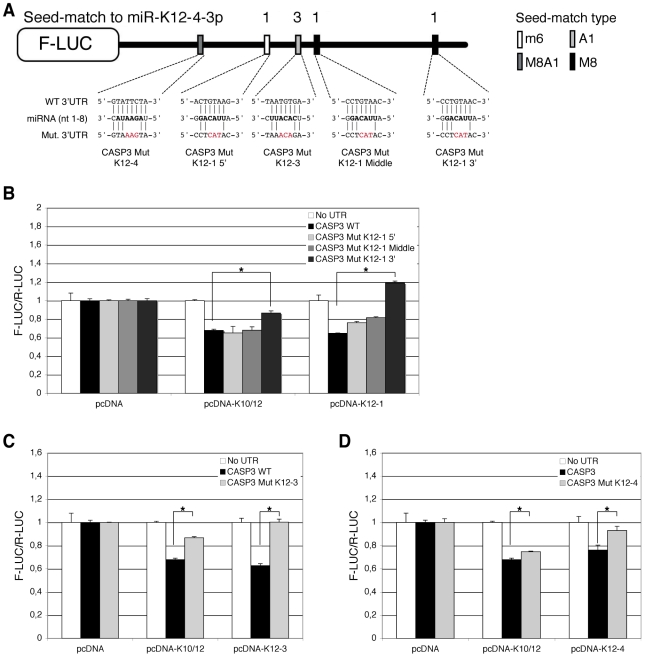
Identification of KSHV miRNAs binding sites in the 3′ UTR of Casp3 transcript by mutational analysis.Luciferase assays were performed multiple times in triplicate, 48 h post-transfection. A. Schematic representation of Casp3 luciferase sensor and of the mutagenesis performed within the potential binding sites of miR-K12-1, miR-K12-3 and miR-K12-4-3p. A mutant was generated for each potential miRNA binding site. Dual luciferase assays were performed with the Casp3 luciferase wild type (WT) or mutant sensors and pcDNA constructs expressing either the K10/12 construct or the individual miRNA miR-K12-1 (B), K12-3 (C) or K12-4-3p (D). Luciferase ratios relative to empty psiCHECK-2 set to 1 are displayed. (* p<0.01).